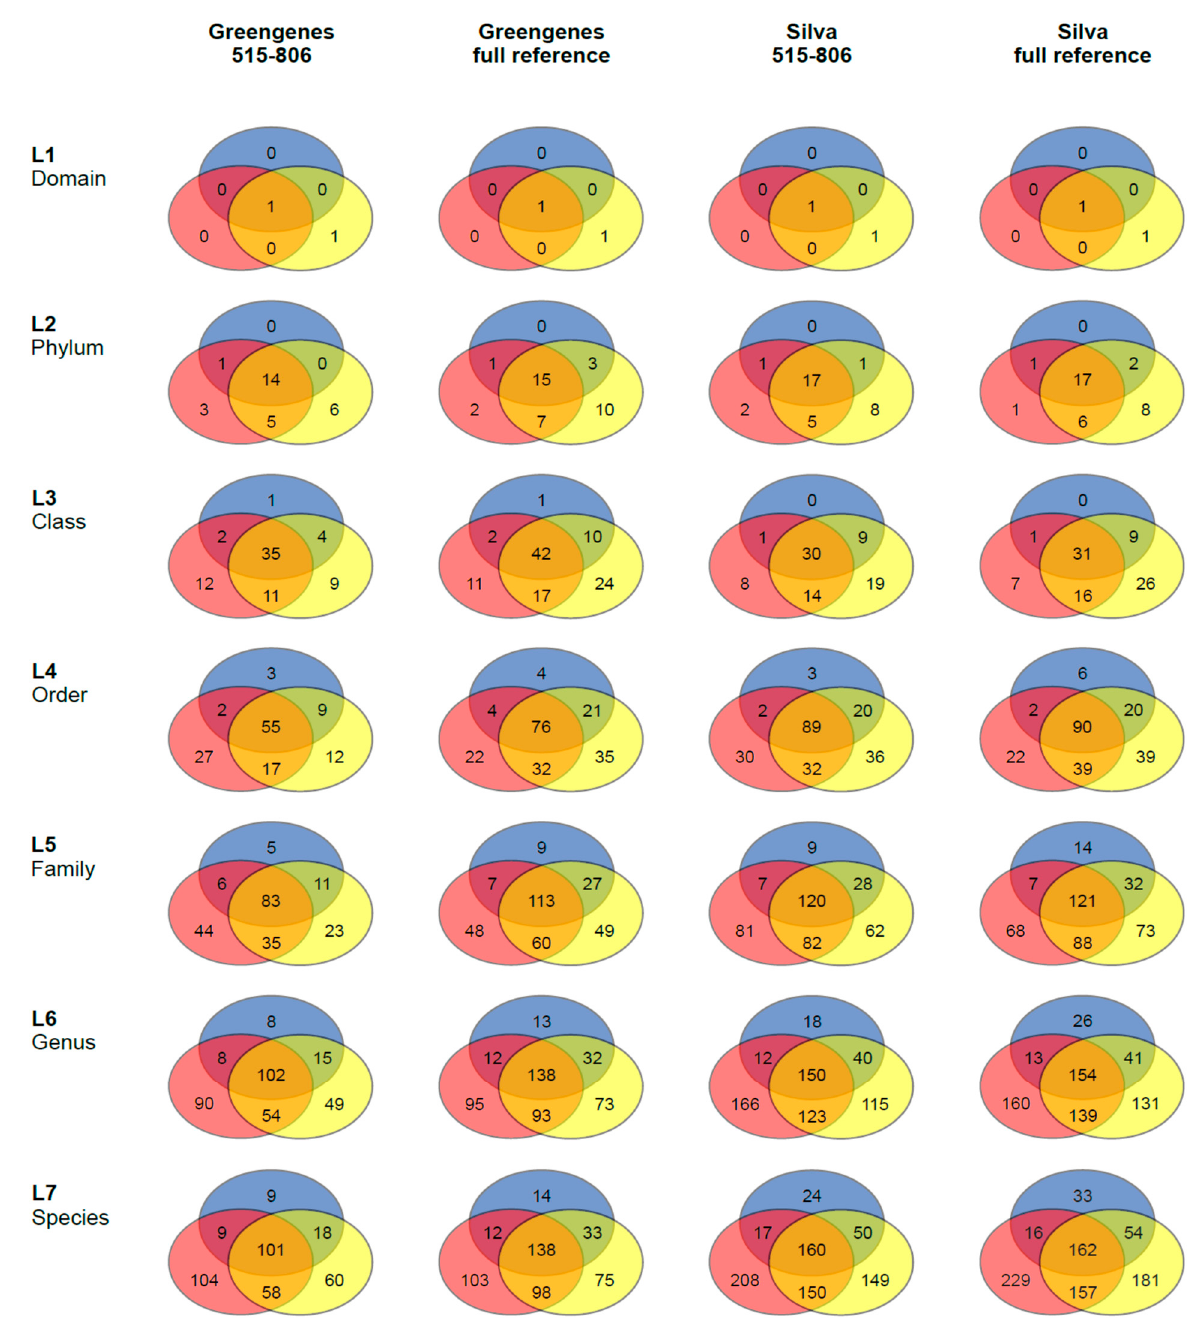
Figure 4. Comparison of two taxonomies (Greengenes and SILVA) and output of the three commercial laboratories (EF: red, GM: blue and MG: yellow) visualized by Venn diagrams that show ASVs at seven taxonomic levels (L1 domain, L2 phylum, L3 class, L4 order, L5 family, L6 genus and L7 species level).